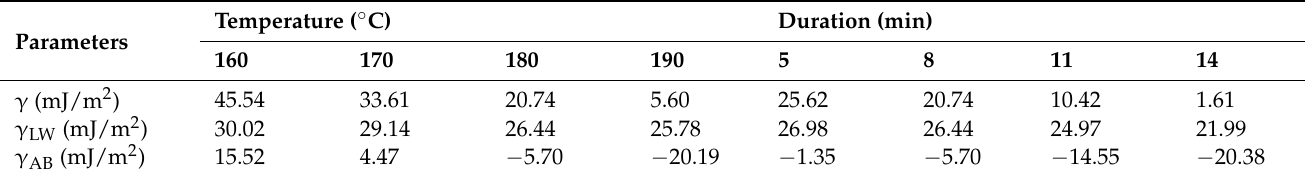
Table 1. Surface free energy of TPM-treated veneers at different temperatures and duration.